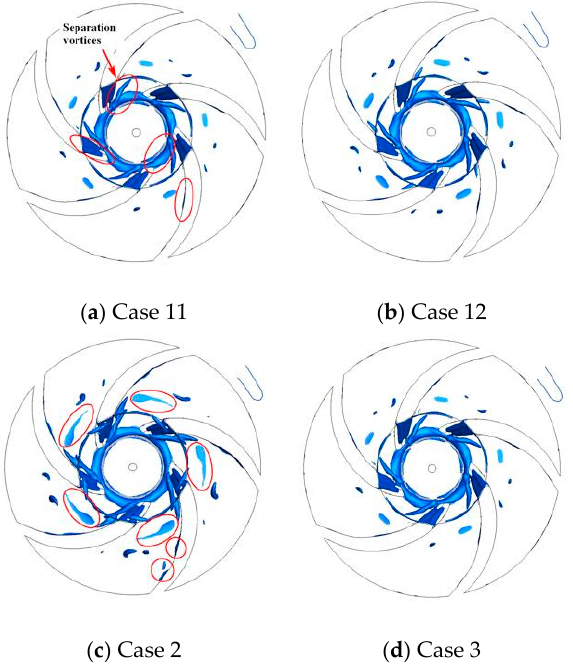
Figure 9 . Distribution of the Q T values in the increasing flow rate section ( Q T = 1.0 × 10 7 ). Figure 9. Distribution of the Q